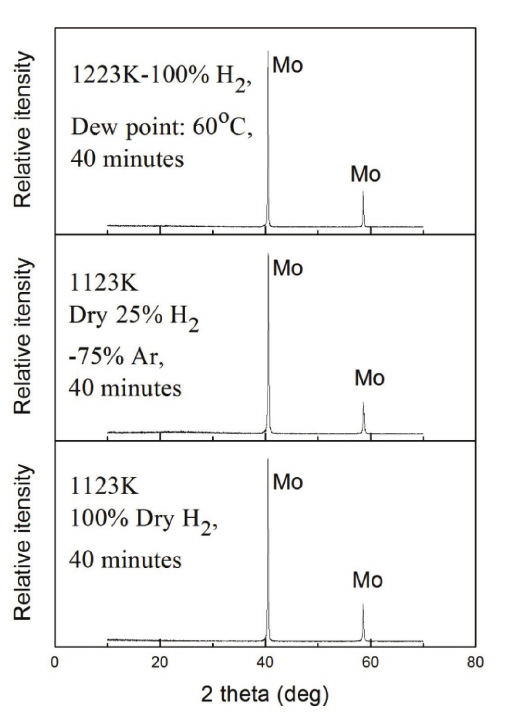
Fig. 3: XRD patterns of samples reduced under different